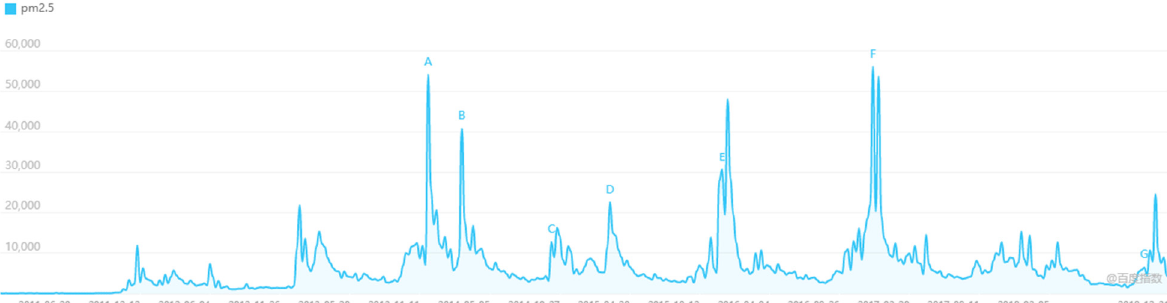
Figure 1. Baidu Index of PM 2.5 from 2011 to 2018. (A–G) represent several concentration peaks of PM2.5 in recent years.